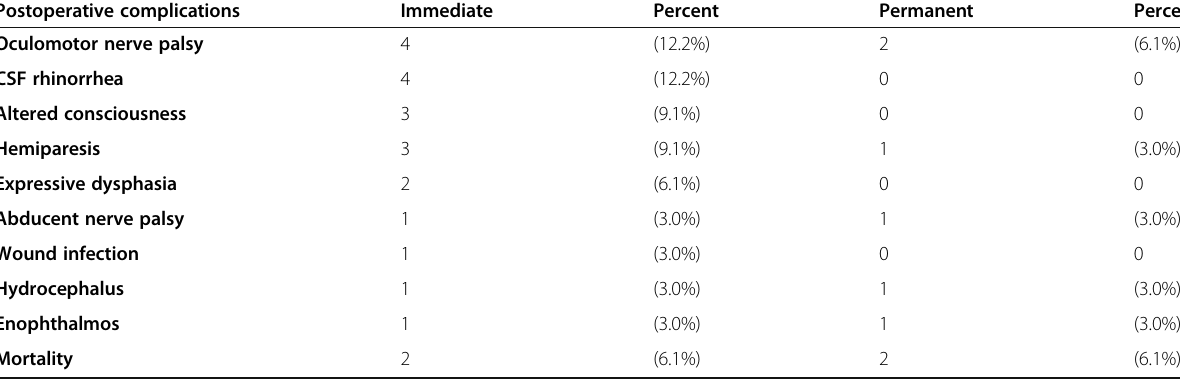
Table 3 Immediate and permanent postoperative